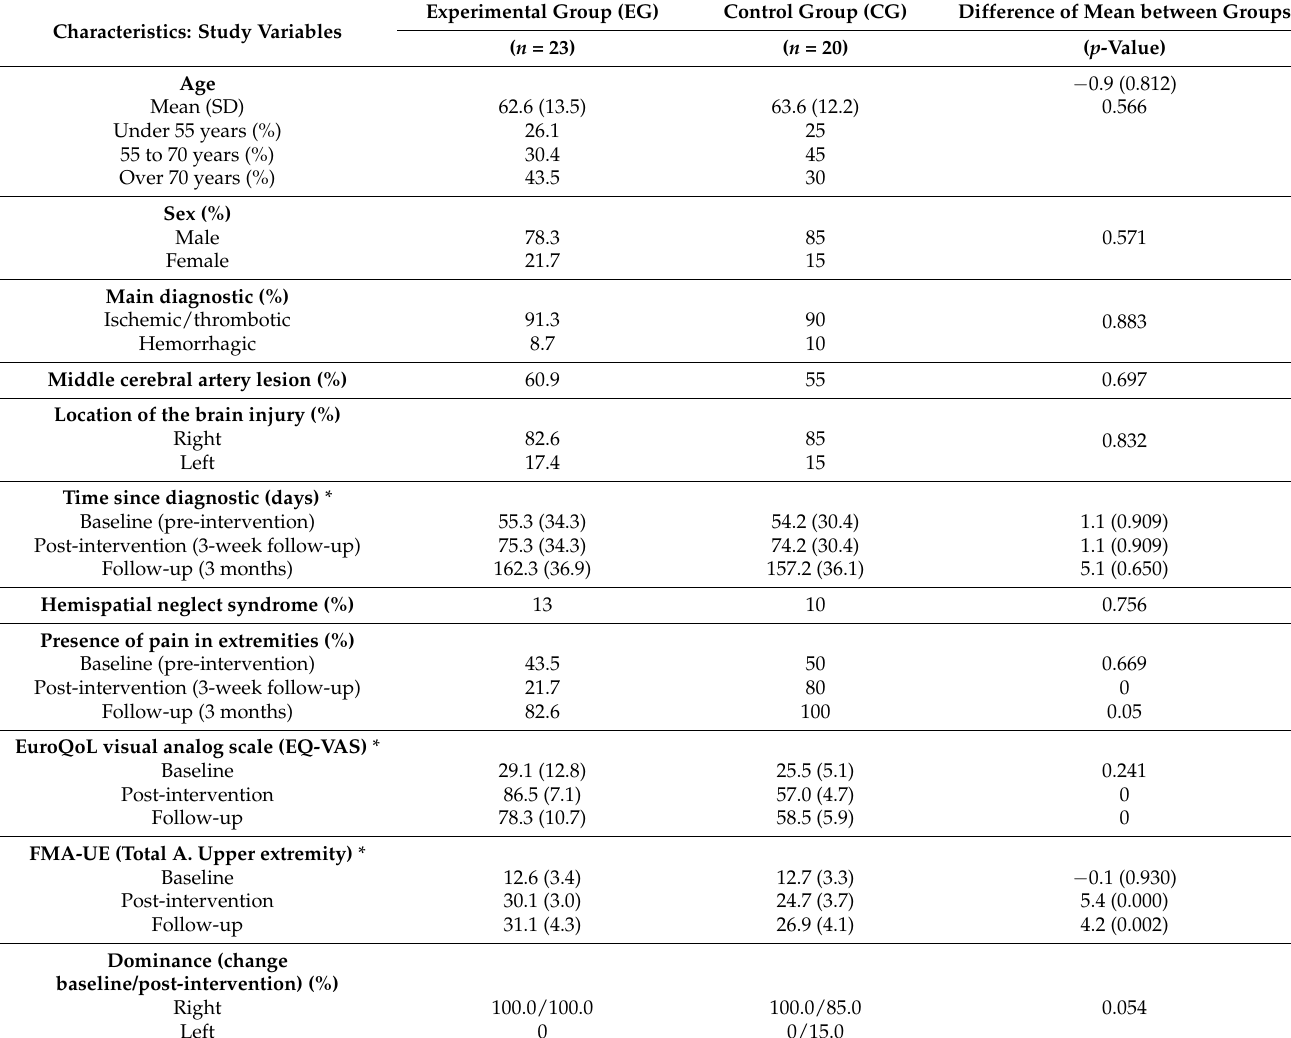
Table 1. Characteristics of the participants of both groups ( n =